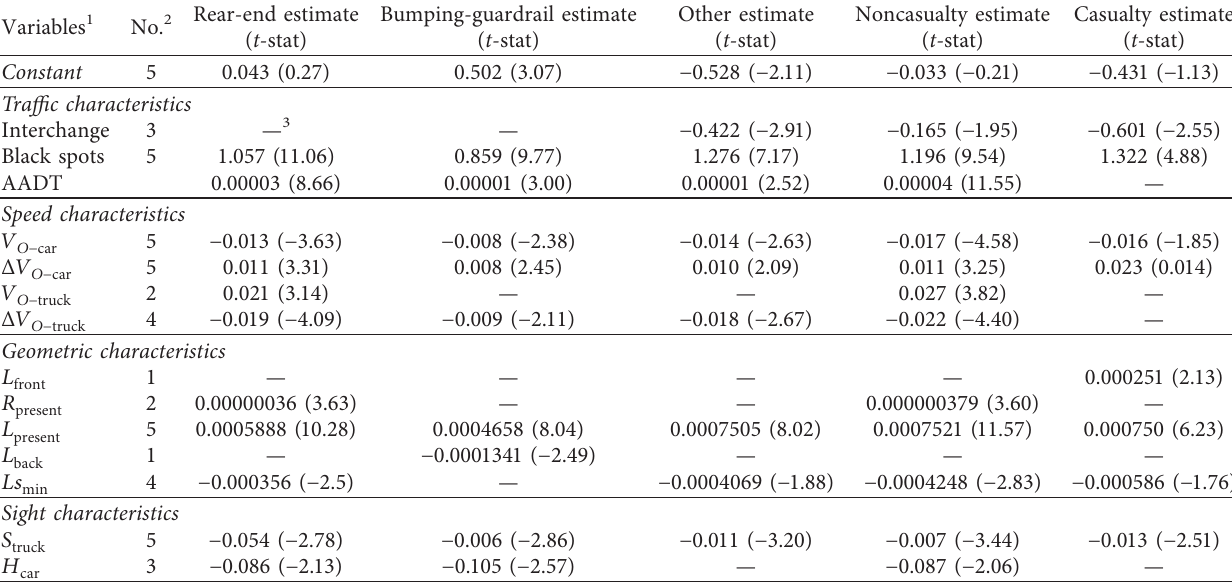
Table 7: Independent negative binomial model estimation results.